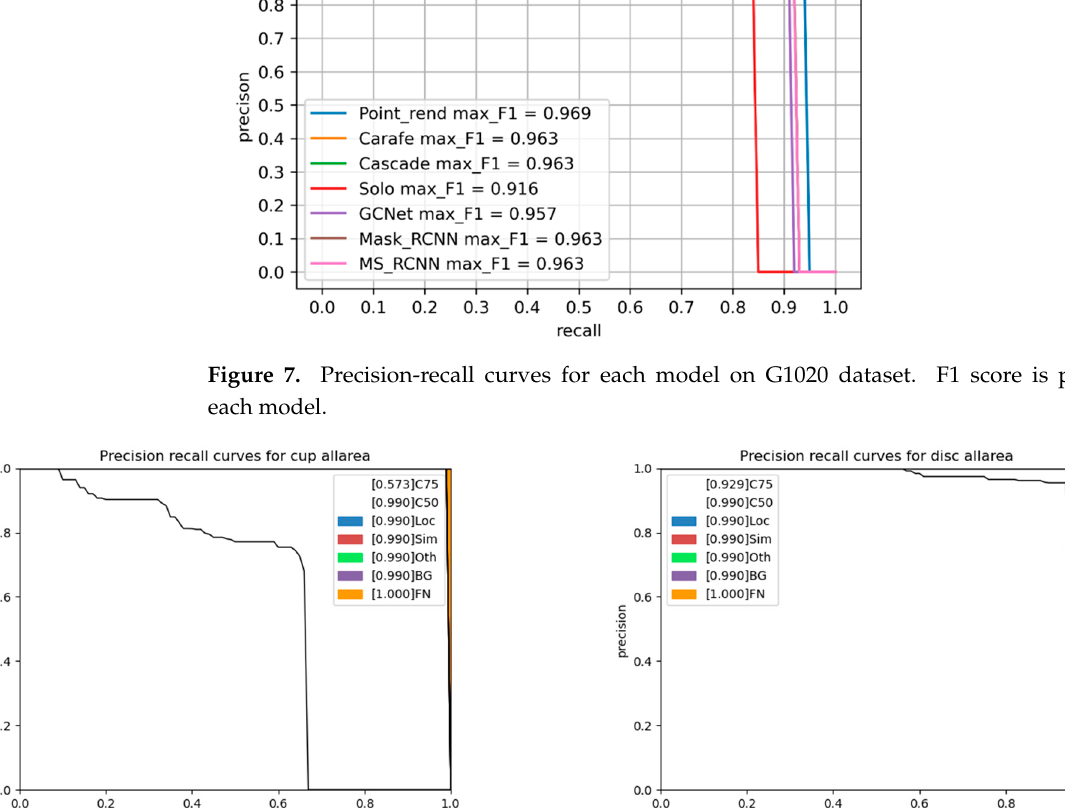
Figure 8. Precision-recall curves per classes in Cascade Mask-RCNN on Refuge dataset. The left image represents the cup area, and the right image the disc area. Both show the presence of false positives.